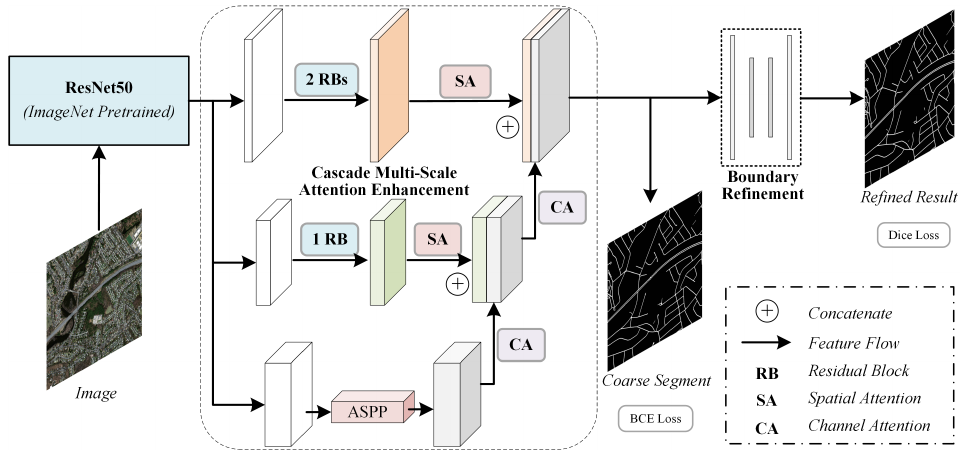
Figure 2. Structure of the proposed